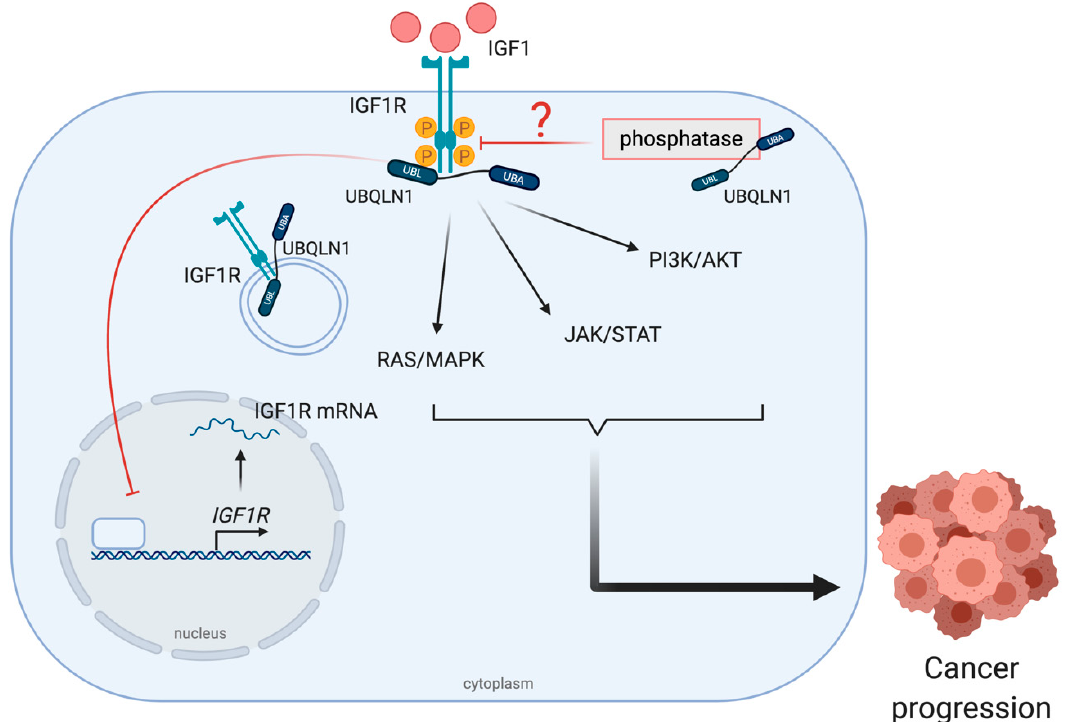
Figure 4. UBQLNs and insulin-like growth factor 1 receptor (IGF1R) networking in cancers. The stabilization of UBQLN1 and IGF1R can be found in various forms such as pro-form, phosphorylated form and normal form. After IGF1R activation, downstream signal transduction pathways including RAS/MAPK, JAK/STAT and PI3K/AKT, are activated to drive cancer progression. The role of UBQLNs in cell membrane receptor stabilization is not limited to IGF1R and its relatives. The regulation is likely observed in gamma-aminobutyric acid A (GABA A ) receptor, G- protein coupled receptors (GPCRs) and nicotinic acetylcholine receptors (nAchRs) [65–68]. Moreover, B1a B-cells and BJAB B-cell lymphoma in the absence of UBQLN1 undergo cell proliferative defects